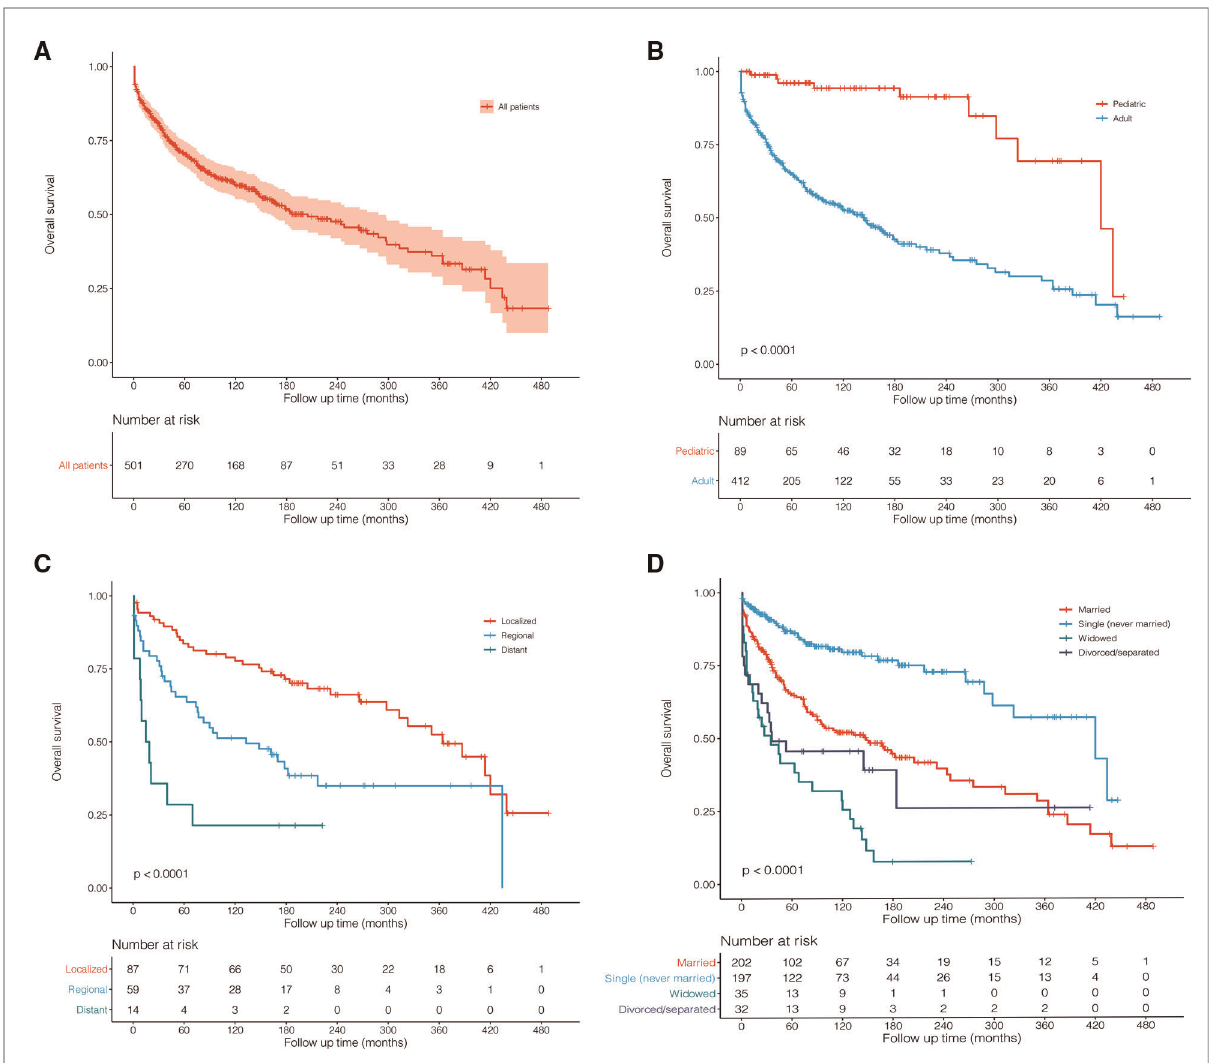
FIGURE 3 Kaplan – Meier survival curves and log-rank tests for possible prognostic factors. ( A ) All 501 patients were diagnosed with primary malignant pituitary tumors between 1975 and 2016 from the SEER 18 Registries Custom Data. ( B ) Age: pediatric and adult. ( C ) Tumor extent: localized, regional, and distant. ( D ) Marital status: married, single (never married), widowed, and divorced/separated.